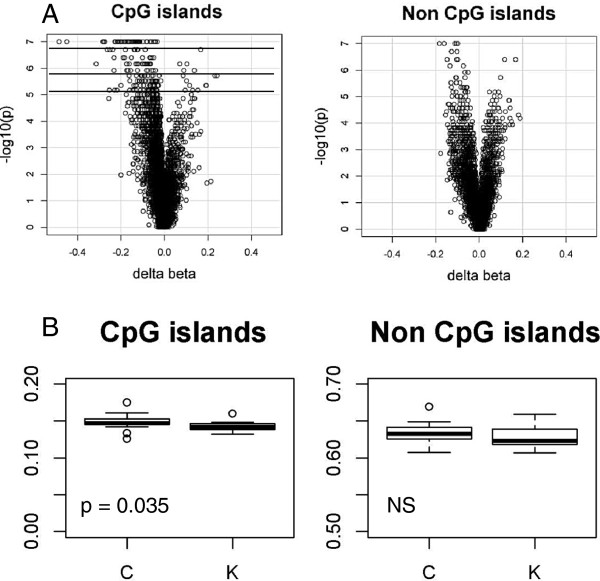
Loss of DNA methylation at CpG islands associated with KDM5C mutations. A) Volcano plot of DNA methylation differences between controls and KDM5C mutation cases (delta beta, X-axis) versus statistical significance –log10(p) in CpG islands (left) and non-CpG islands (right). Negative delta beta represents loss and positive delta beta gain of DNA methylation in KDM5C mutation cases. Black lines represent p-values at three levels of confidence 95% (6.69E-06), 99% (1.07E-06) and 99.5% (2.00e-07). B) Boxplot of the mean methylation of all microarray probes within CpG islands (left) and non-CpG islands (right) in controls (C) and in KDM5C mutations cases (K).